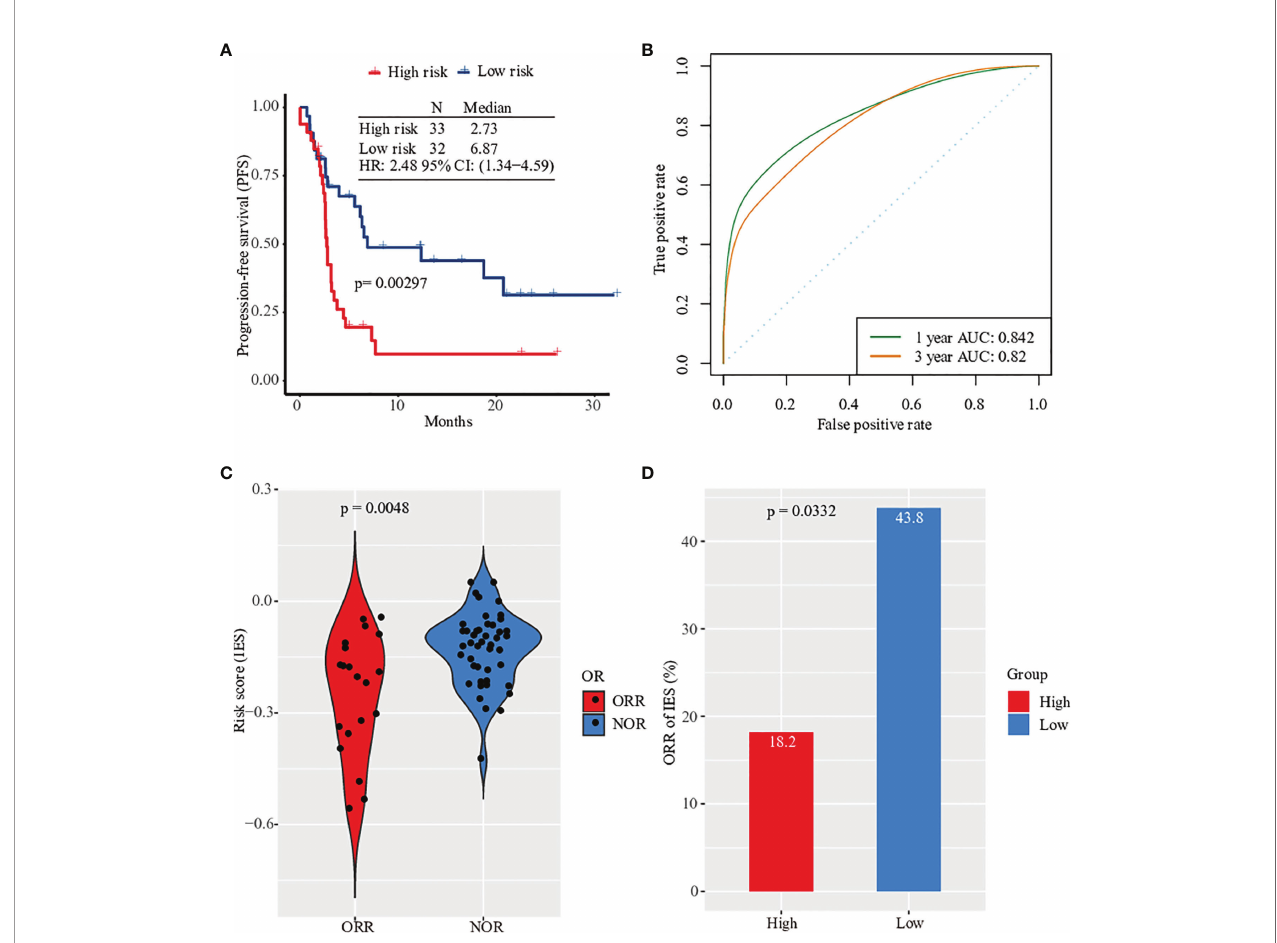
FIGURE 2 | Prognosis and clinical response prediction with gene expression pro fi le. (A) Kaplan – Meier survival curves of PFS in high-risk patients versus low-risk patients based on Prat pan-cancer anti-PD-1 monotherapy cohort. (B) Sensitivity and speci fi city of the prognosis risk score model were assessed by time- dependent ROC analysis. (C) Violionplot of the distribution of risk score value between patients with ORR and NOR. (D) Barplot of object response rate between the high risk group and the low risk